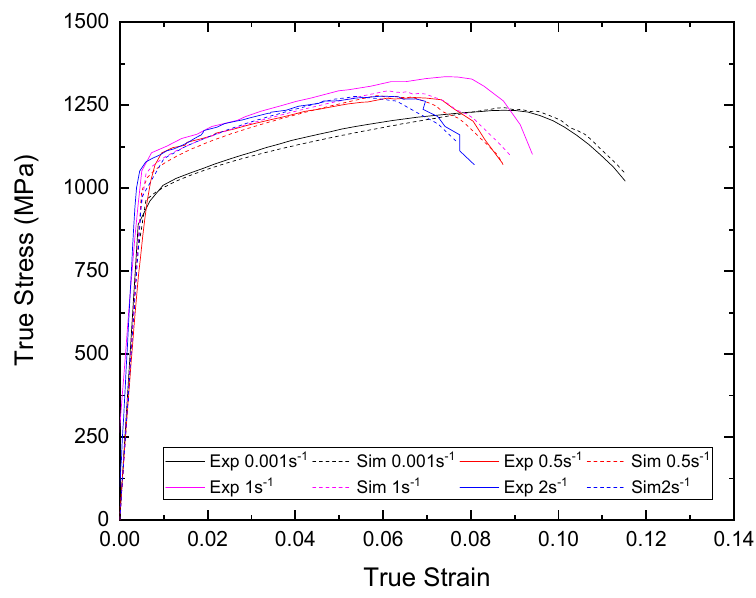
Figure 14. Comparison between experimental (Exp, continuous lines) and FE simulation (Sim, dotted lines) results for 0.001 s − 1 –2 s − 1 strain rates.